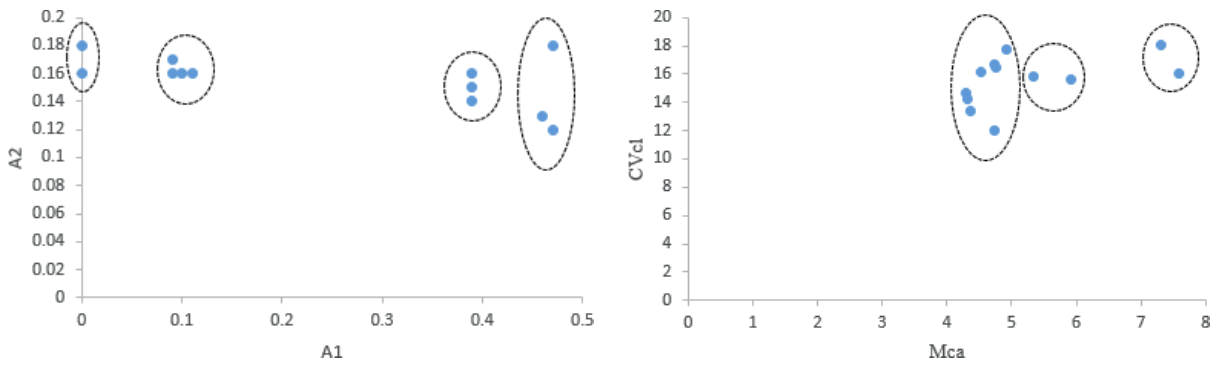
Figure 5. Scatter diagram of 12 berry species: Romero-Zarco asymmetry indices (a), CVCL and MCA (b).